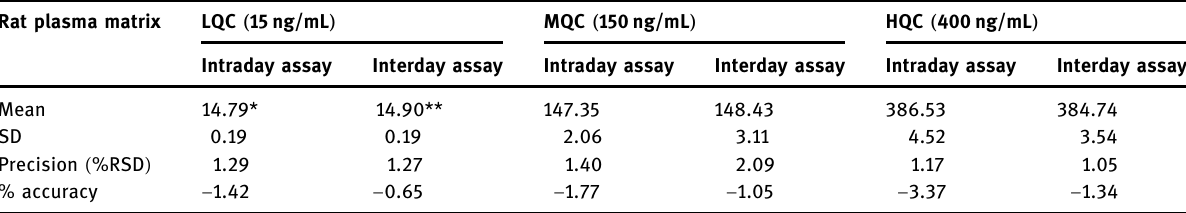
Table 3: Intraday and interday ( accuracy and precision ) of the established method Rat plasma matrix